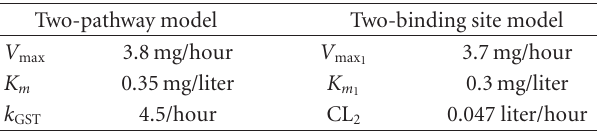
Table 2: Optimized parameter